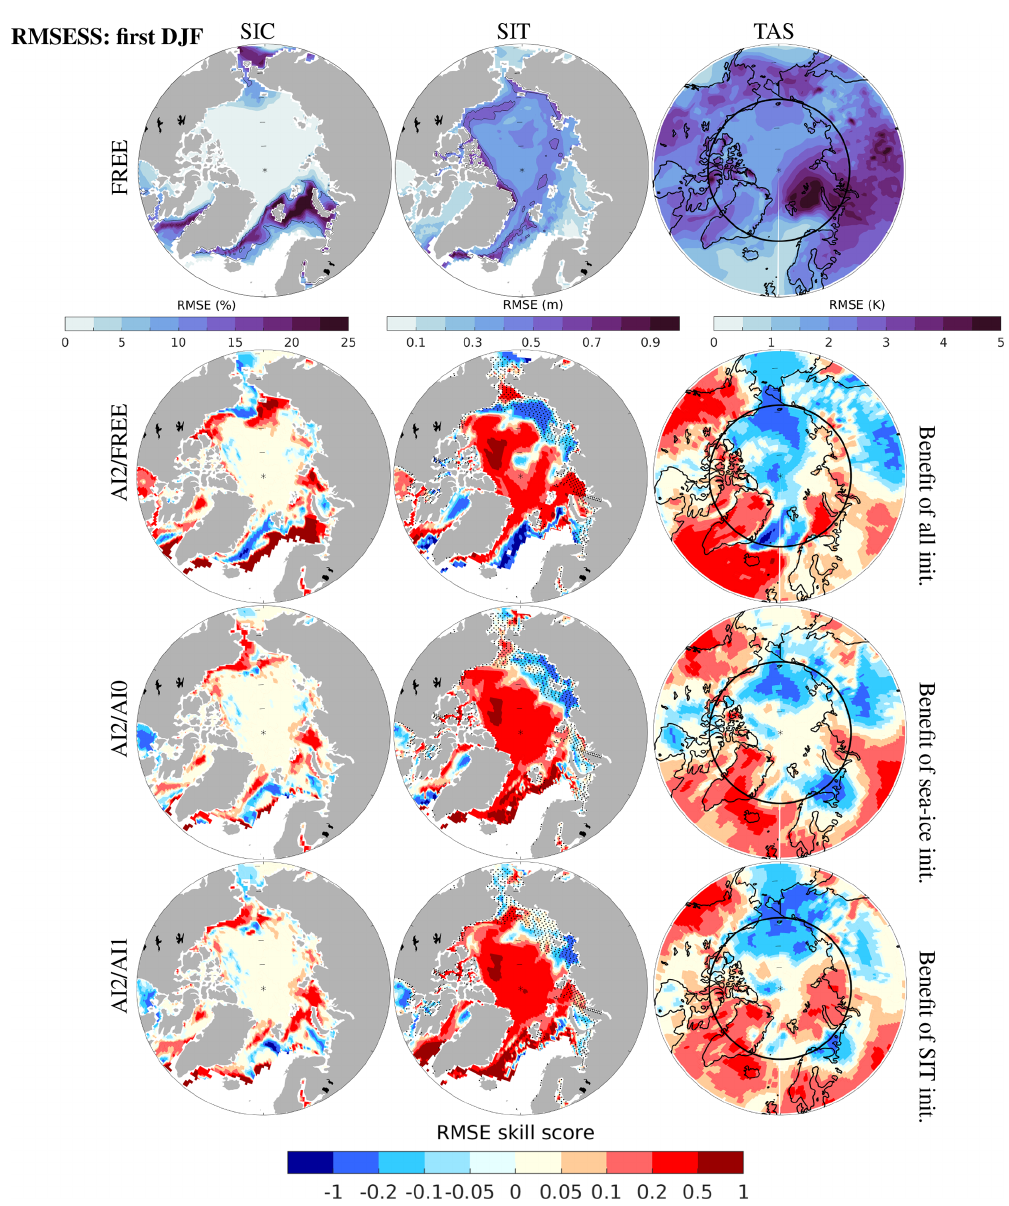
Figure 6. RMSE of FREE with respect to REF (top row) and RMSE skill score (lower rows) for the first wintertime (DJF) forecast: SIC (left), SIT (centre) and TAS (right). The contour lines mark RMSE ≥ 10% or 0.5m for SIC and SIT, respectively. The RMSE skill score is calculated as 1 − ( RMSE AI2 / RMSE INIT ) , where INIT denotes FREE (no init.), AI0 (no sea ice init.) and AI1 (no SIT init.). Scores above 0 denote more accurate in AI2 than INIT, and vice versa. Note that the label of the colour bar for skill score is asymmetric because the minimum of the skill score (SS) can be far below − 1 in contrast to the maximum of 1. The stippled areas in the middle columns are the same as in Fig.